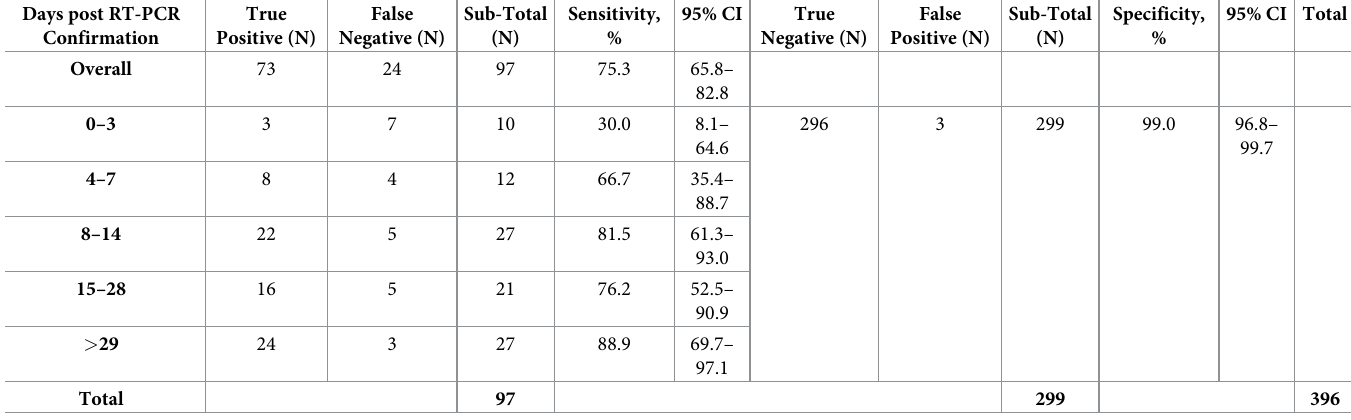
Table 2. Sensitivity by days post RT-PCR confirmation and specificity of xMAP SARS-CoV-2 Multi-Antigen IgG Assay using the NIMR panel and 2018 NAIIS pre- pandemic samples, Nigeria, 2021. Days post RT-PCR